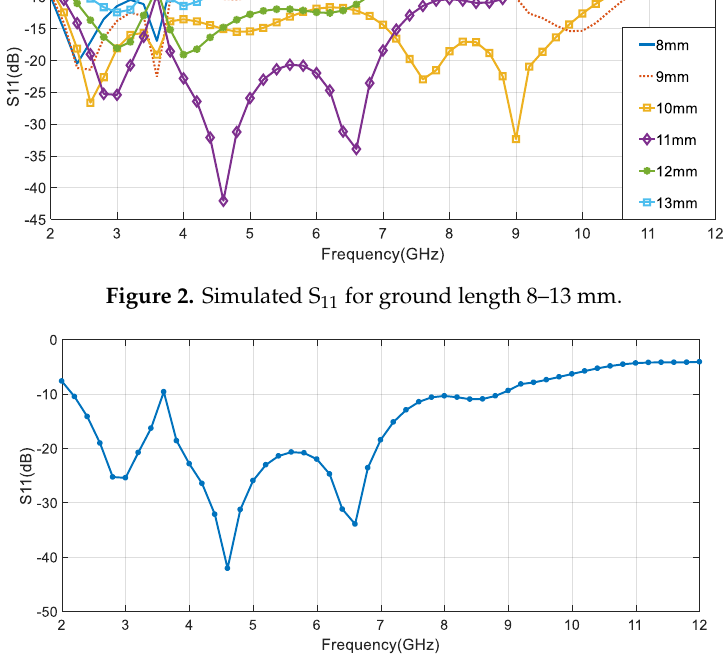
Figure 3. Simulated S 11 for the optimal value of ground length 11 mm.